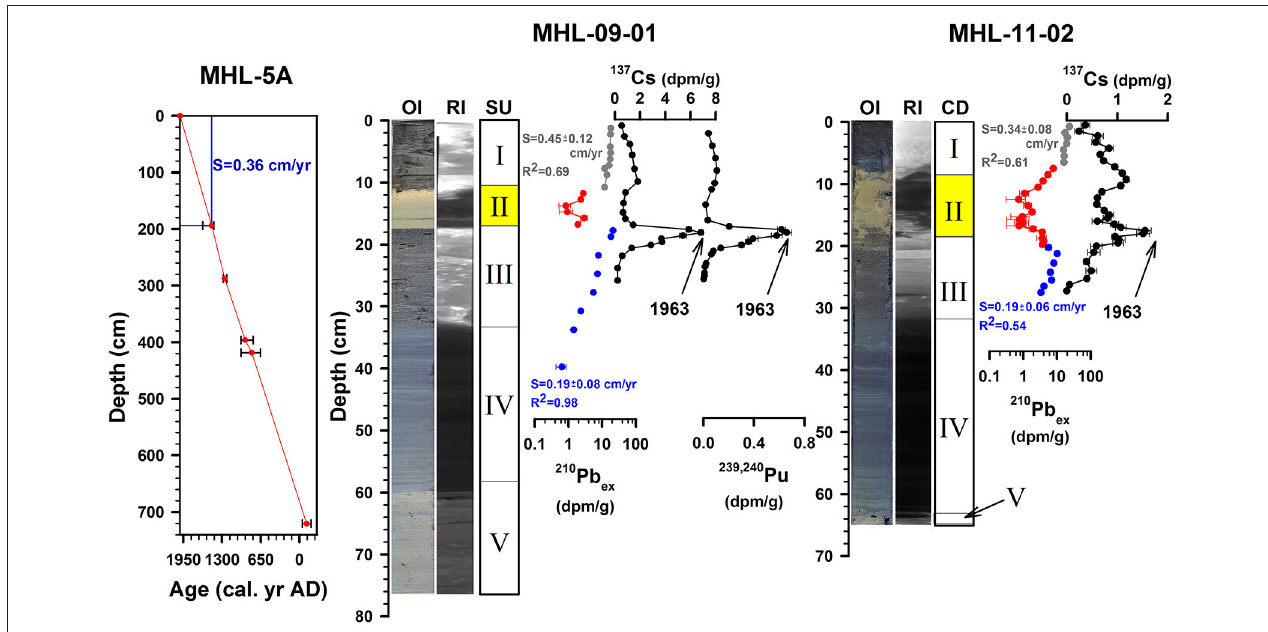
FIGURE 2 | The depth vs. radiocarbon age profile of the upper 720cm in MHL-5A, and the lithologies and chronologies for core MHL-09-01 and MHL-11-02. The blue box in the left panel shows the segment that was used for palynological reconstruction. This interval has a mean sedimentation rate of 0.36cm yr − 1 , which is close both to the average of the age model in MHL-5A, and in agreement with the sedimentation rates reconstructed for the two shorter cores. OI: optical image obtained by Itrax-XRF core scanner; RI: radiographic image obtained by Itrax-XRF core scanner; SU: Sedimentary units. The chronologies are based on the radionuclide profiles of 210 Pb ex , 137 Cs and, 239,240 Pu in core MHL-09-01 and 210 Pb ex and 137 Cs in MHL-11-02. The 210 Pb-based sedimentation rates above (in gray color) and below unit II (in blue color) in both cores are also shown next to the 210 Pb ex profiles.